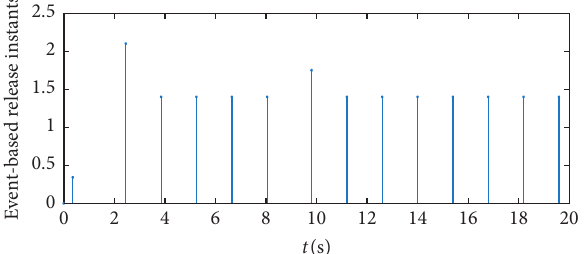
Figure 8: The release instants and release interval of state x 2 ( t ) under the distributed event-triggered scheme with constant parameter σ .